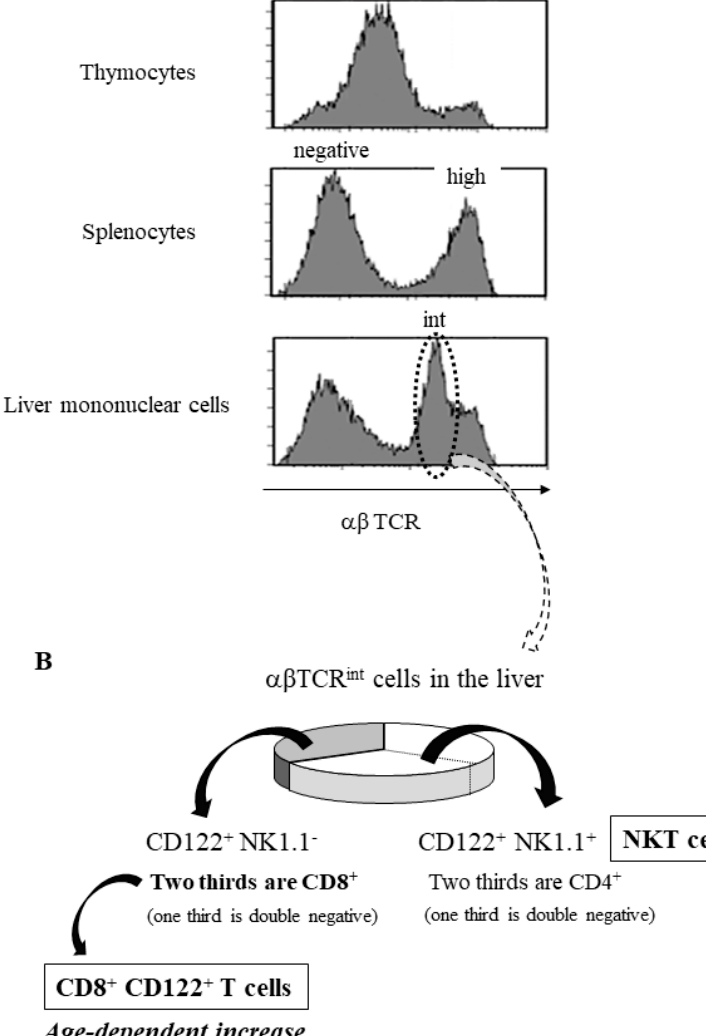
Figure 3. T cell receptor (TCR) intensity in lymphocytes of the thymus, spleen, and liver along with subsets of liver TCR-intermediate cells. ( A ) Immature CD4 + CD8 + double-positive cells show dull TCR intensity in thymocytes, mature T cells show high TCR intensity in the splenocytes, and NKT and CD8 + CD122 + T cells show intermediate TCR intensity in the liver mononuclear cells (indicated by dotted circle). ( B ) TCR-intermediate cells in the liver include CD122 + NK1.1 + cells (NKT cells; two thirds are CD4 + ), and CD122 + NK1.1 − cells (two thirds are CD8 + ). The cells of this CD8 + subset are called CD8 + CD122 + T cells and demonstrate an age-dependent increase Figures are revised from